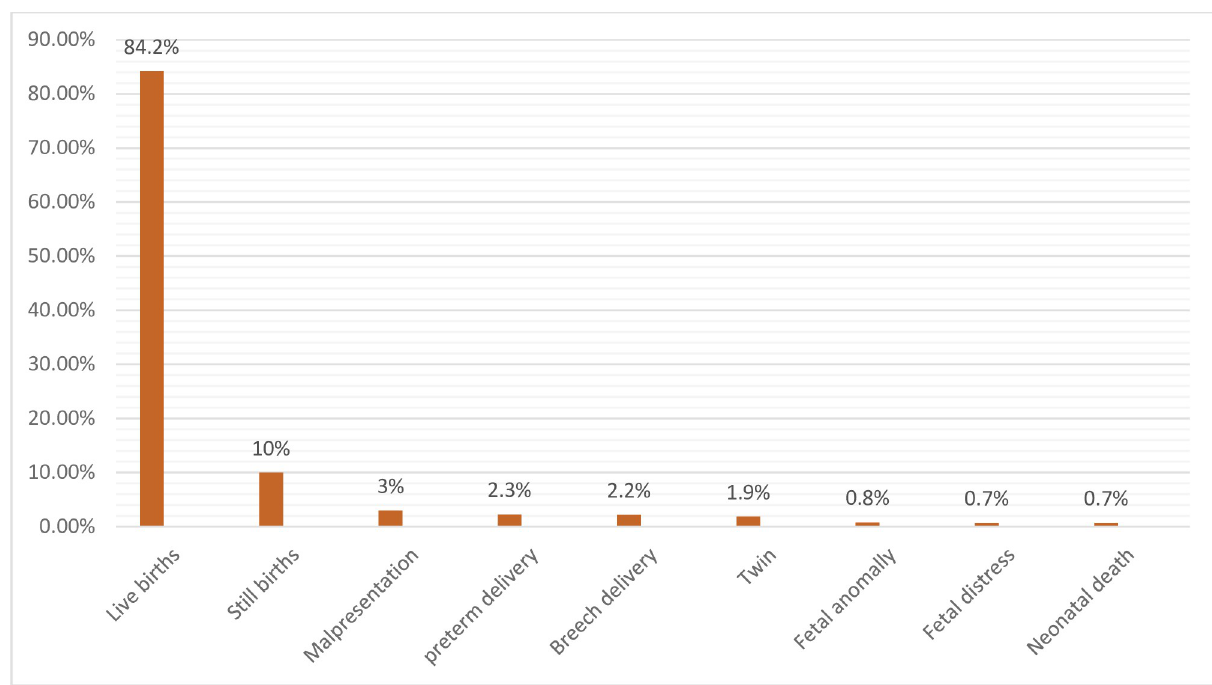
Fig 2. Fetal or neonatal outcome at Debre Berhan Comprehensive Specialized Hospital, Northeast Ethiopia.